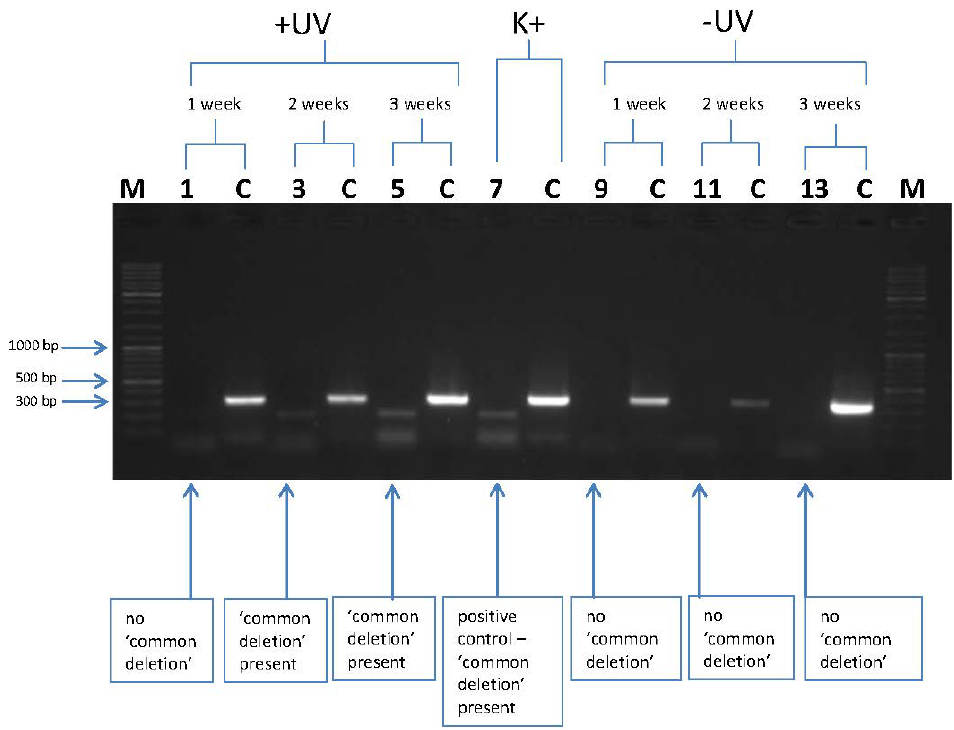
Figure 2. Representative PCR analysis of the presence of the “common deletion” in a culture of human fibroblasts incubated with and without UVA exposure, without the presence of L -ergothioneine. M, molecular weight marker; C, control PCR reaction, confirming the presence of mtDNA; 1, fibroblasts after 1 week with UVA exposure; 3, fibroblasts after 2 weeks with UVA exposure; 5, fibroblasts after 3 weeks with UVA exposure; 7, positive control—DNA from a patient with a previously confirmed presence of “common deletion”; 9, fibroblasts after 1 week without UVA exposure; 11, fibroblasts after 2 weeks without UVA exposure; 13 fibroblasts after 3 weeks without UVA